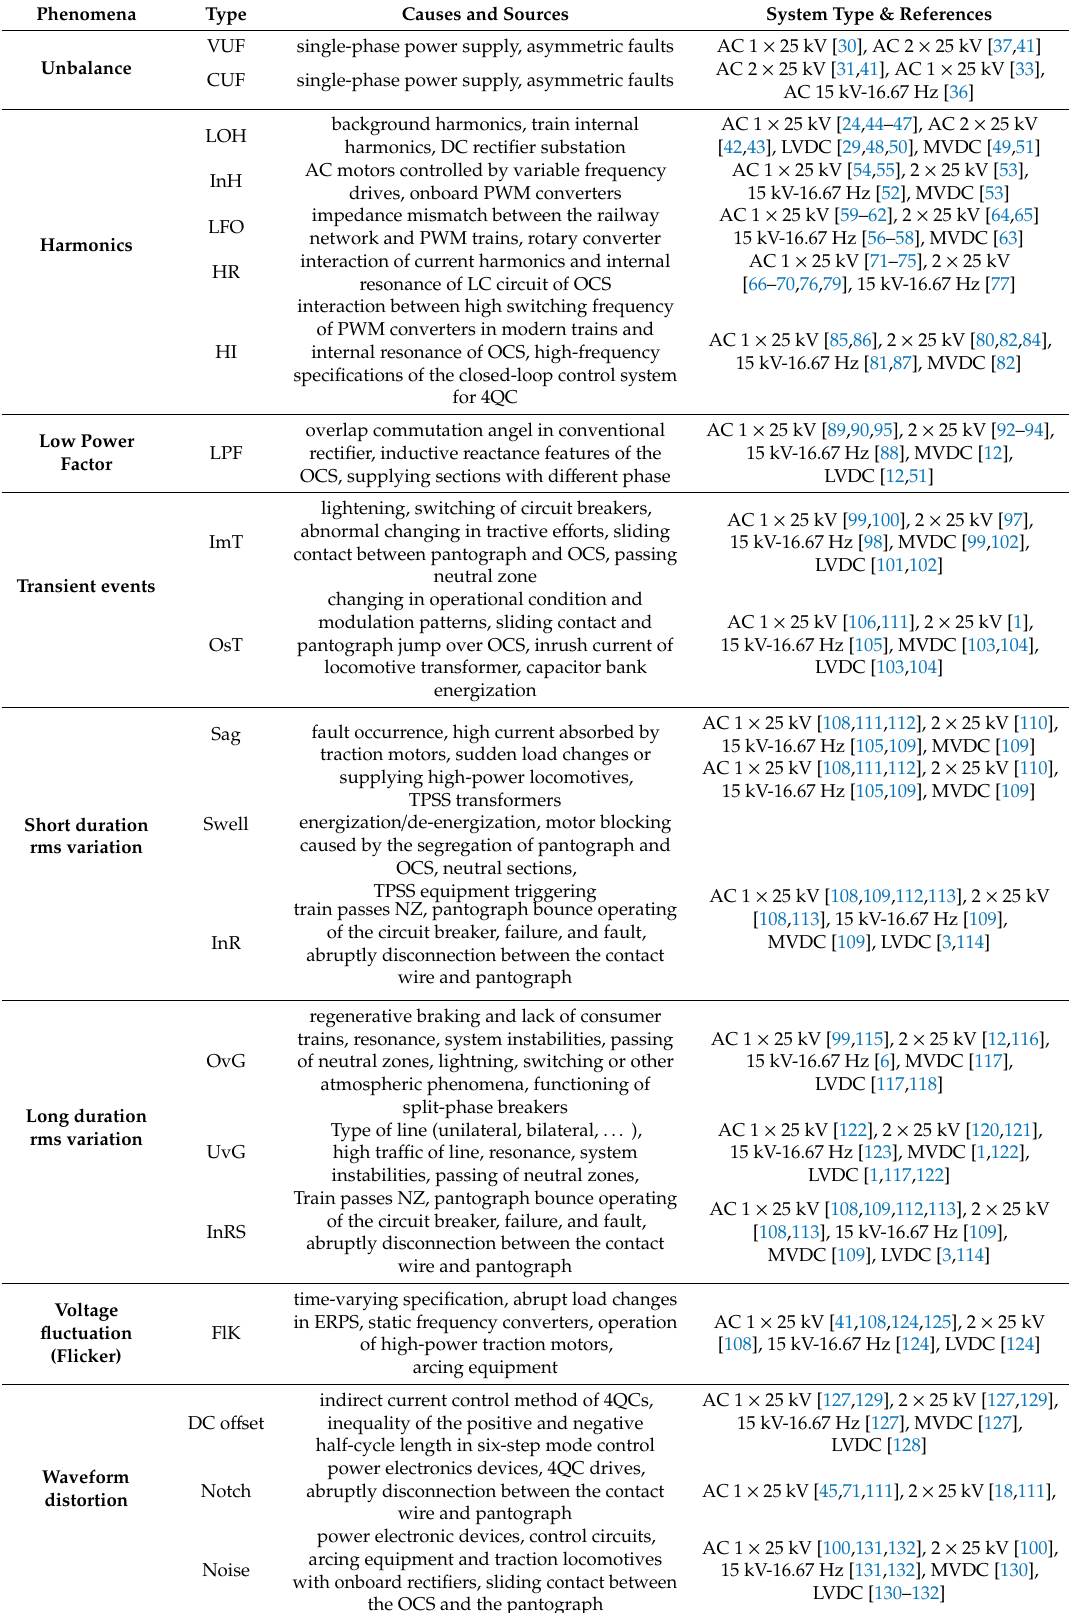
Table 3. Reported classified PQ indexes in di ff erent